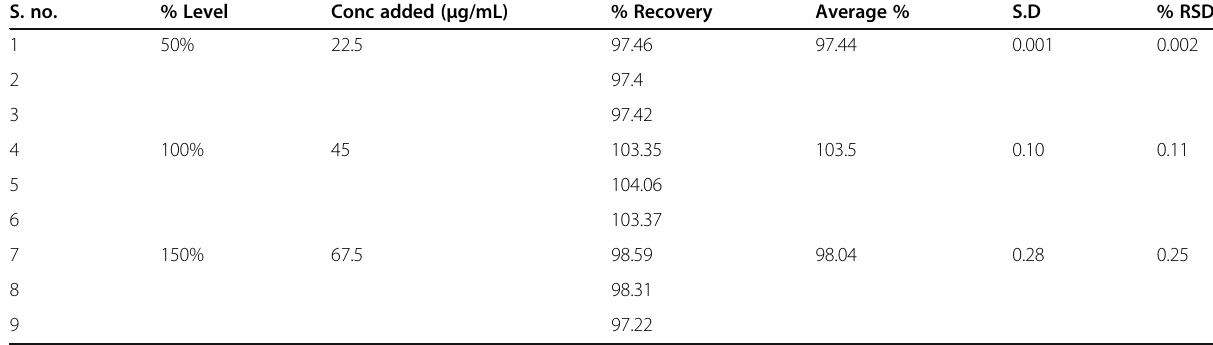
Table 9 % Recovery of Ivacaftor in human plasma S.